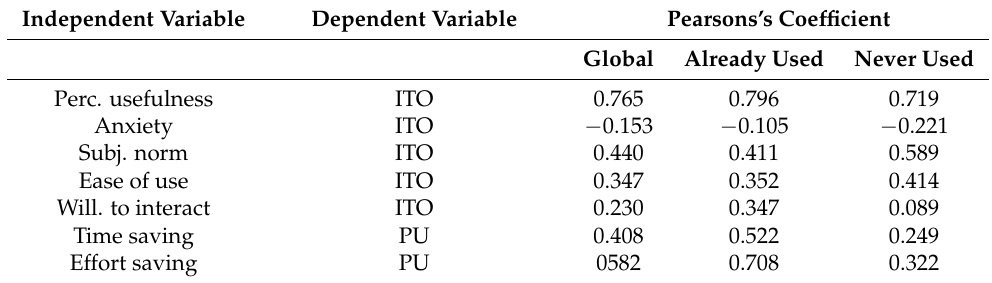
Table 6. Comparison of the correlations between the variables of the model. Global values refer to the analysis of the whole dataset. “Already used” refers to data coming from participants who had already used exoskeletons, and “never used” refers to data coming from those who did. Independent Variable Dependent Variable Pearsons’s Coefficient Global Already Used Perc. usefulness